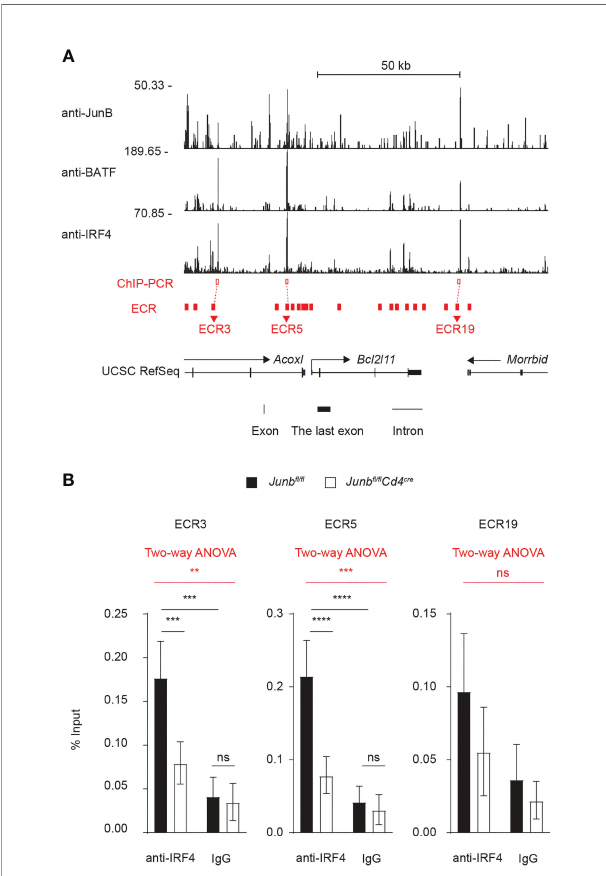
FIGURE 7 | JunB is critical for IRF4 binding to the Bcl2l11 locus (A) Naive CD4 + T cells from Junb fl / fl mice were activated under Th1-polarizing conditions for 48 h and subjected to ChIP-seq analysis using JunB, BATF, and IRF4 antibodies. ChIP-seq peaks for JunB, BATF, and IRF4 on Bcl2l11 locus are shown. Three JunB/BATF/IRF4-colocalizing ChIP-seq peaks (red open box) were detected at regions close to evolutionarily conserved regions: ECR3, ECR5, and ECR19 of Bcl2l11 locus (red fi lled box). Transcription directions (arrows), transcription start sites (TSS, turn right arrows), exons (black vertical lines and boxes) and introns (black solid lines) are indicated. (B) Naive CD4 + T cells from control ( Junb fl / fl ) or Junb -de fi cient ( Junb fl /f Cd4 Cre ) mice were activated under Th1-polarizing conditions for 48 h and subjected to ChIP analysis using IRF4 antibodies. Eluted DNA was analyzed by qPCR using primers to detect genomic regions near ECR3, ECR5 and ECR19 (red open boxes shown in (A) . Error bars indicate s.e.m (n = 6 wells per group). The signi fi cance of IRF4 binding on each genomic region was fi rst tested by using two-way ANOVA, as shown on the top of each graph and highlighted in red. The difference lying on each group was tested by using Tukey test, as shown within each graph. ** p < 0.01, *** p < 0.001, **** p < 0.0001, ns non-signi fi cant ( p > 0.05). Data represent a combination of two independent